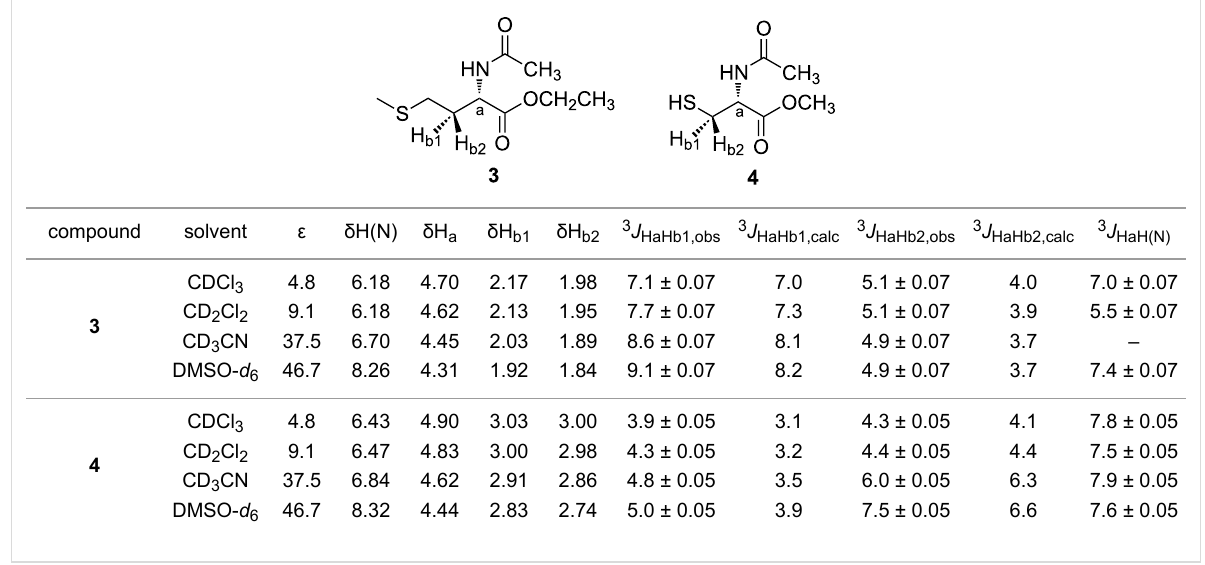
Table 6: Experimental and calculated 1 H NMR data for the compounds 3 and 4 in different solvents. The chemical shifts values are given in ppm and the 3 J HH coupling constants in